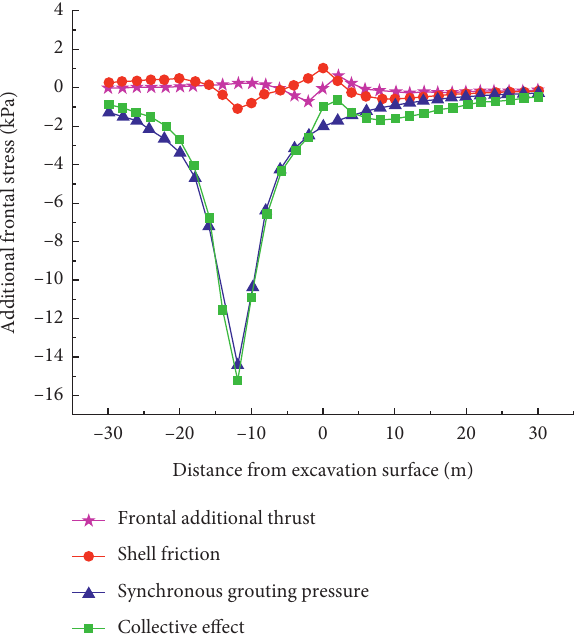
Figure 6: The distribution of the additional stress σ axis.